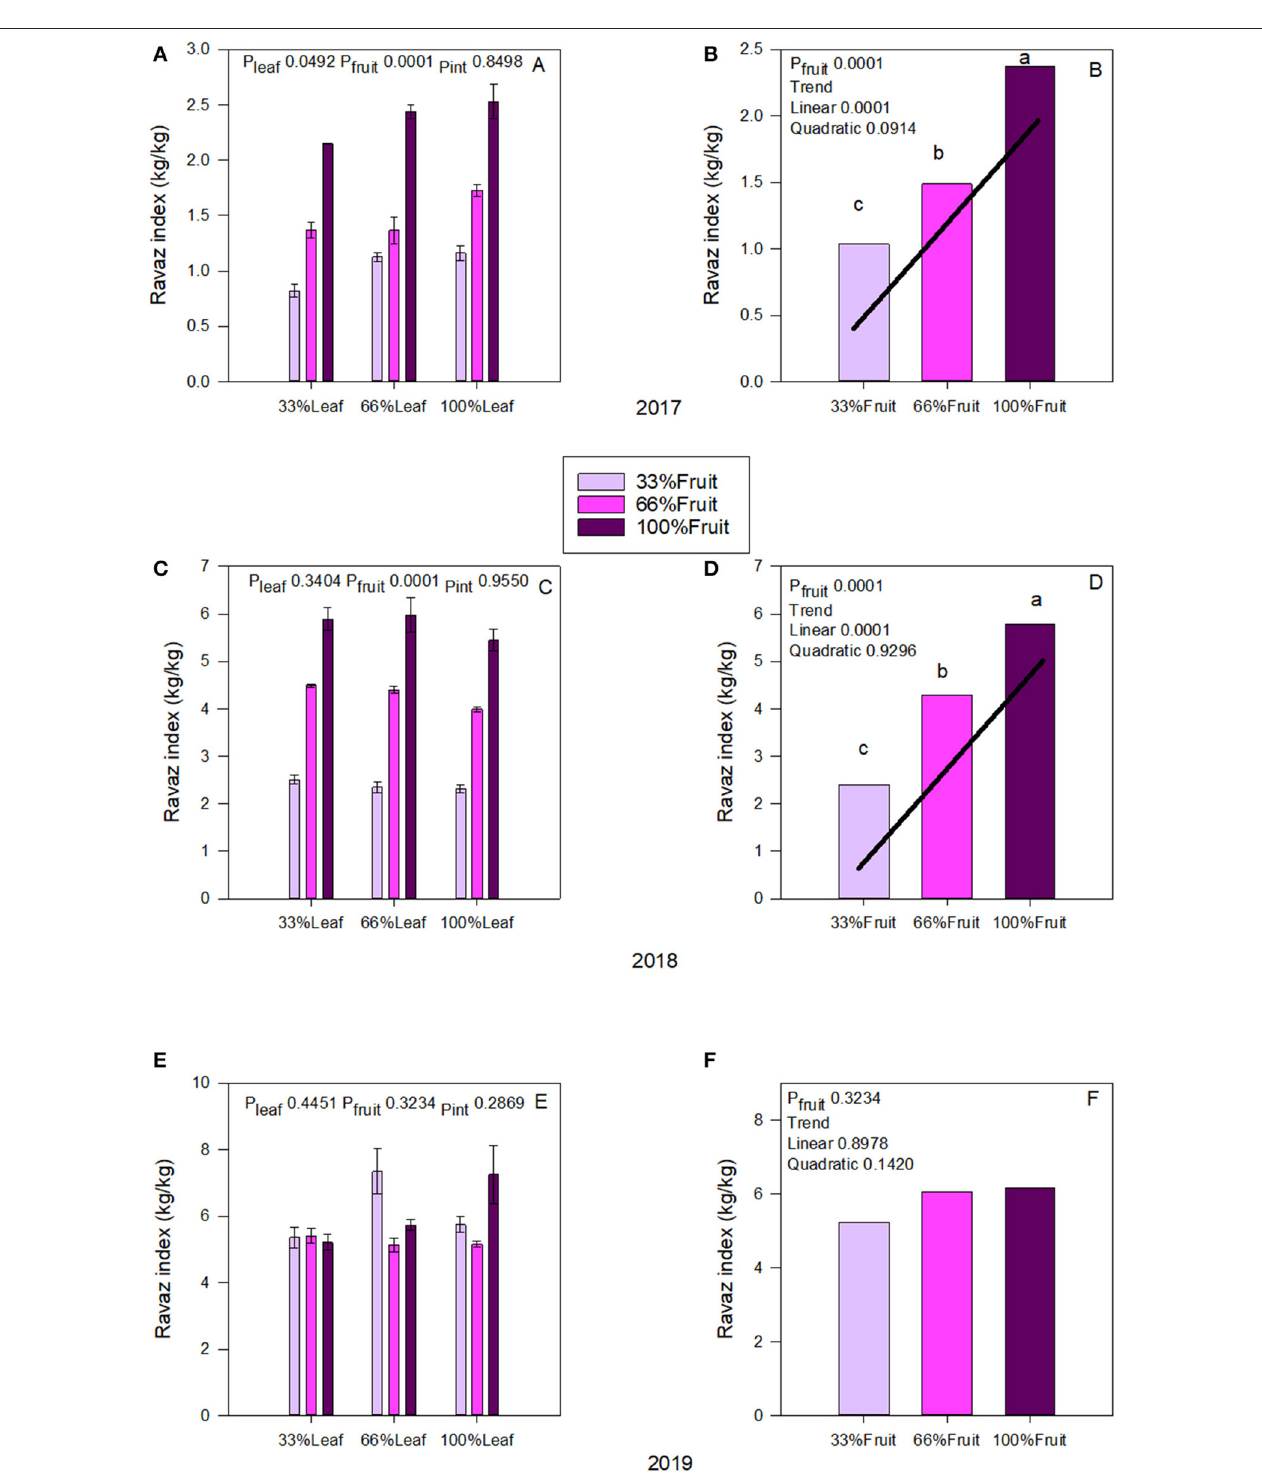
FIGURE 4 | Effect of defoliation and fruit removal on yield and pruning mass (Ravaz Index) on Cabernet Sauvignon grapevine in 2017 (A,B) ; 2018 (C,D) , and 2019 (E,F) . The interactive effects and simple means with standard error of the mean in each year are presented in (A,C,E) . The main effects of fruit removal with significant trend lines are presented in (B,D,F) . Columns with different letters in main effect panels are significantly different at P < 0.05 according to Tukey’s HSD.